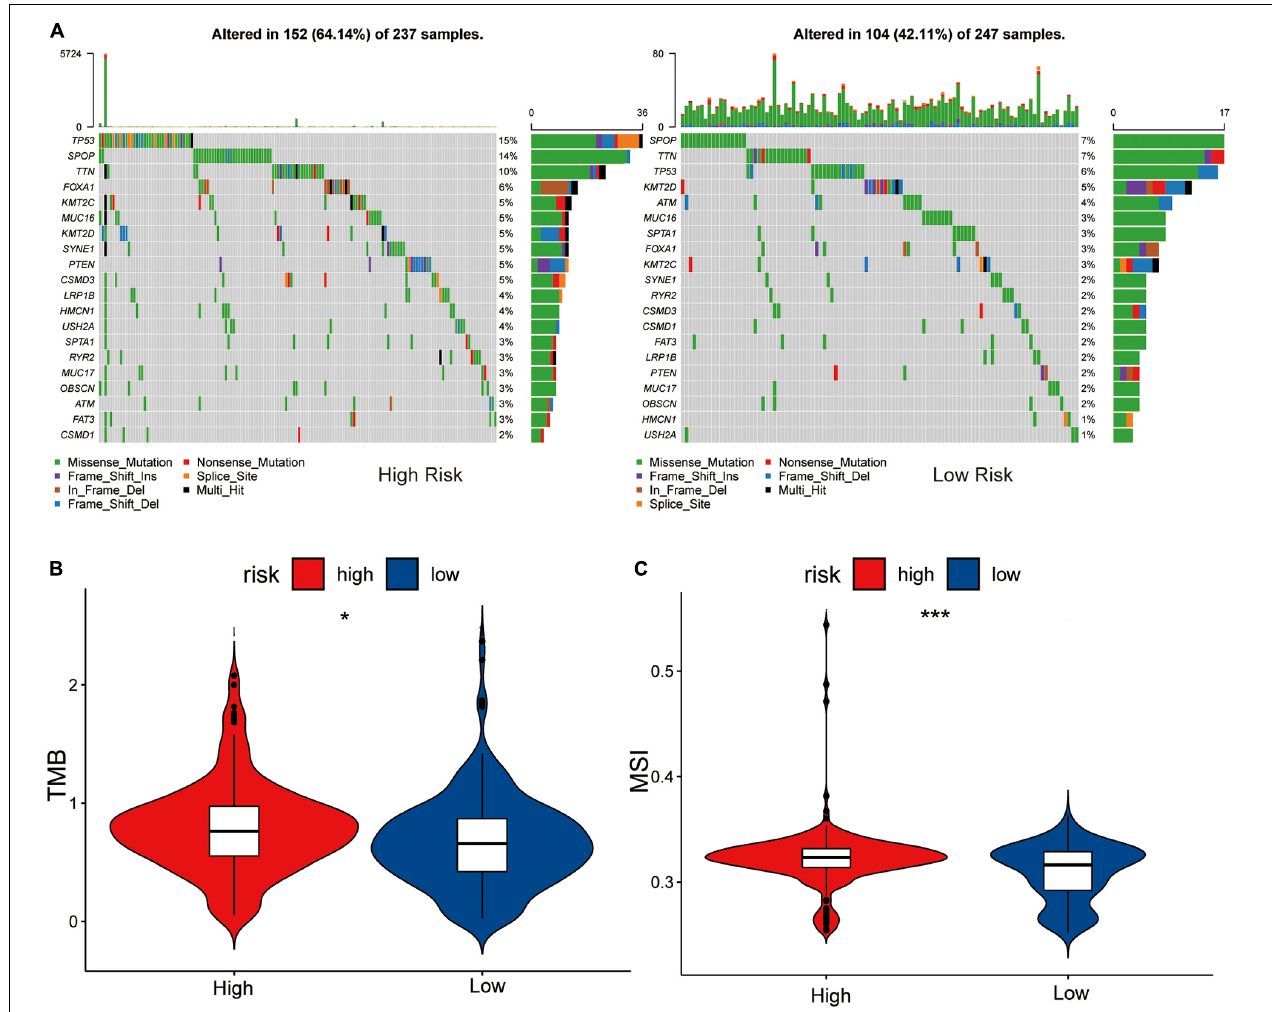
FIGURE 5 | Association between high-low risk groups and DNA mutation. (A) The waterfall plot of the top 20 genes of DNA mutation in high-low risk groups. The pairwise comparison of TMB (B) and MSI (C) between high-low risk groups. The P values are labeled above each boxplot with asterisks (ns: represents no significance, * P < 0.05, *** P <